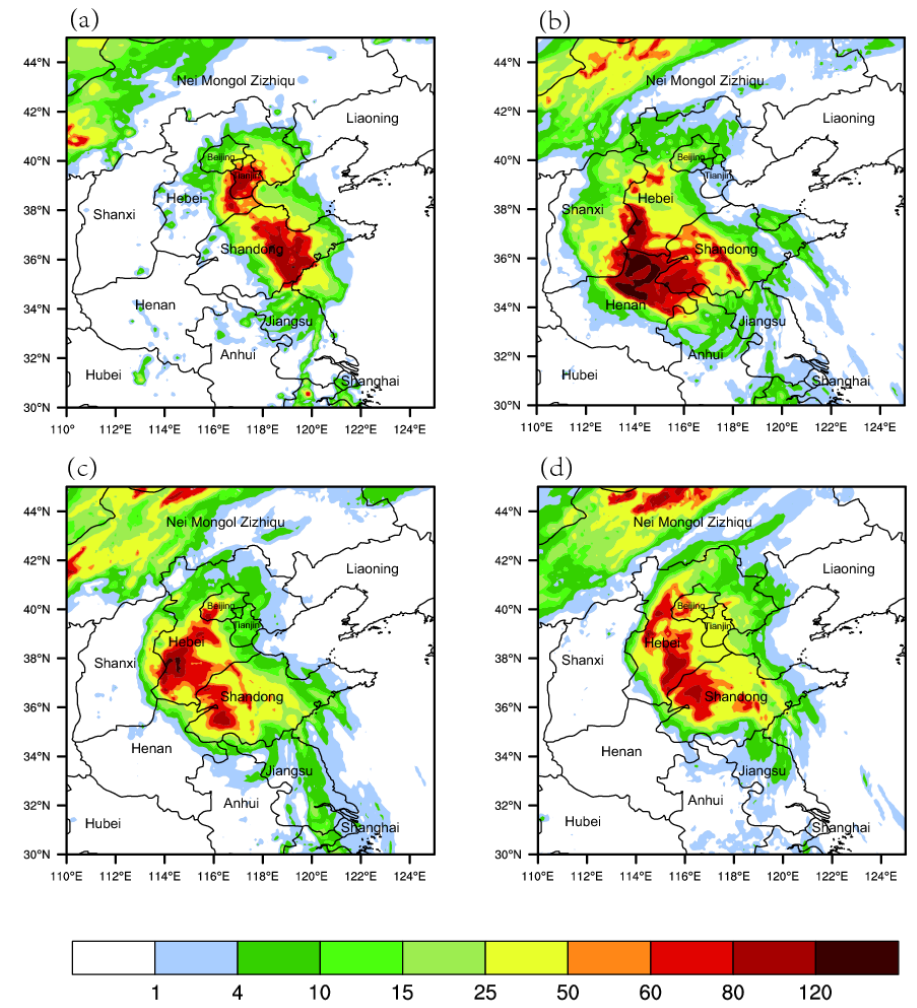
Figure 15. 24-h precipitation distribution of ( a ) the observation, ( b ) the CONV experiment, ( c ) the 3DVar experiment, and ( d ) the EnVar experiment from 0000 UTC on 23 July to 0000 UTC on 24 July 2018.